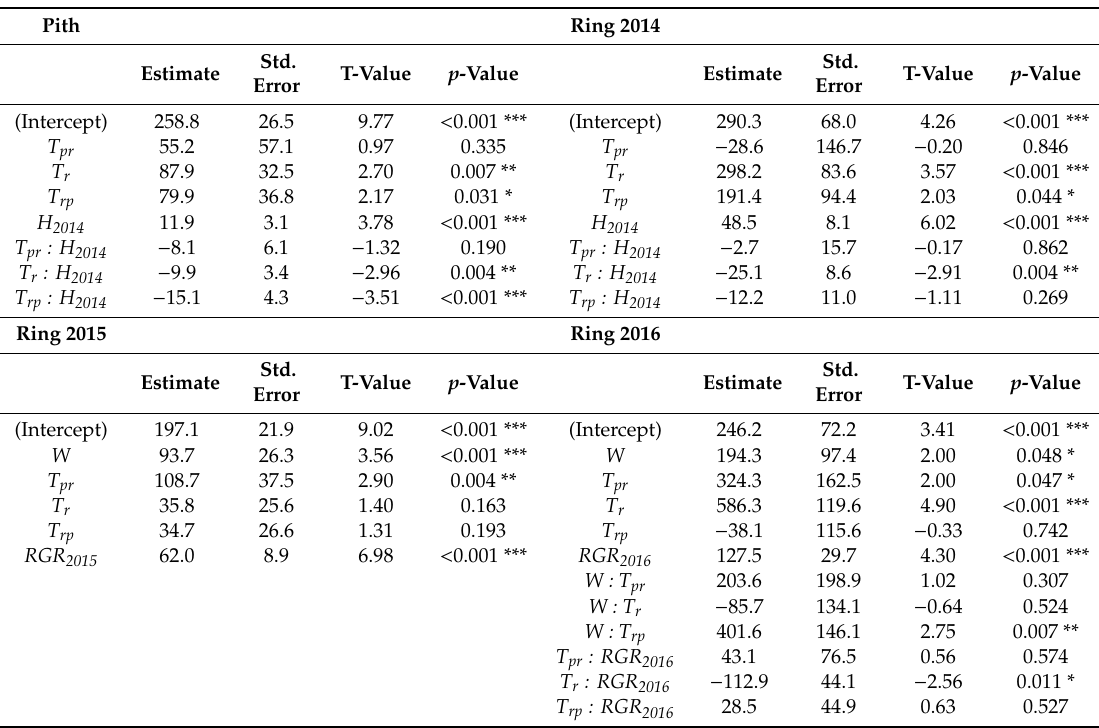
Table 2. Model statistics for the response variables pith radius and ring widths in 2014, 2015 and 2016. The standard level of the categorical variable taxon of the mother tree ( T ) was Q. petraea , to which the other taxa were compared with. T pr : long stalked intermediate form, T r : Q. robur , T rp : short-stalked intermediate form. H 2014 : height at the end of the first growing season. RGR 2015 and RGR 2016 : relative growth rates in height for 2015 and 2016, respectively. W : adjusted relative extractable water in